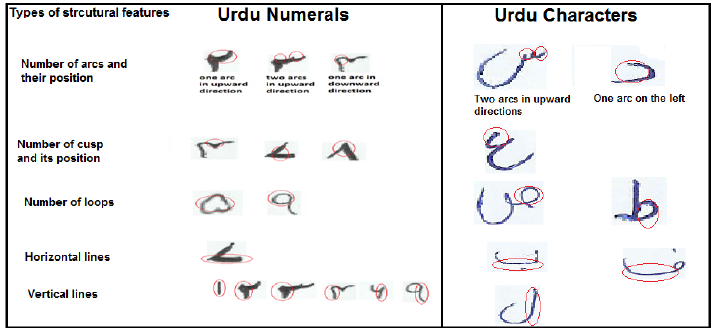
Figure 12. Details of the types of structural (geometrical) features of Urdu characters and